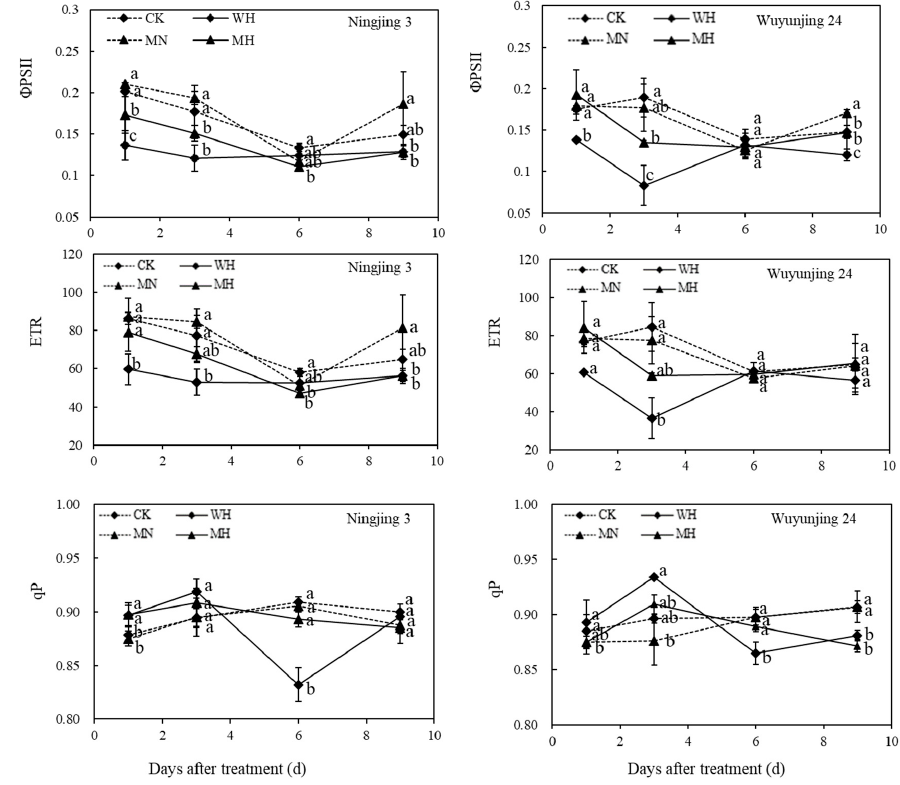
Figure 2. Effects of exogenous MeJA on Φ PSII, ETR, and qP of rice flag leaf at the booting stage under high temperatures. Note: CK: natural temperature and sprayed with water; MN: natural temperature and sprayed with MeJA; WH: heat stress and sprayed with water; MH: high temperature and sprayed with MeJA. Φ PSII: actual photochemical efficiency; ETR: photosynthetic electron transport rate; qP: photochemical quenching coefficient. Bars are the standard deviation. Values followed by different letters are significantly different at the 5% probability level.